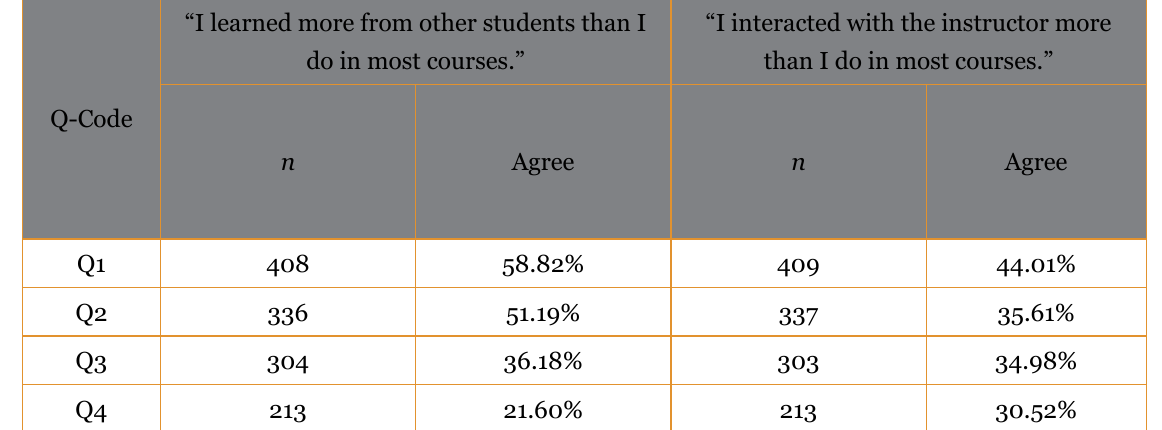
Q1 408 58.82% 409 44.01% Q2 336 51.19% 35.61% 304